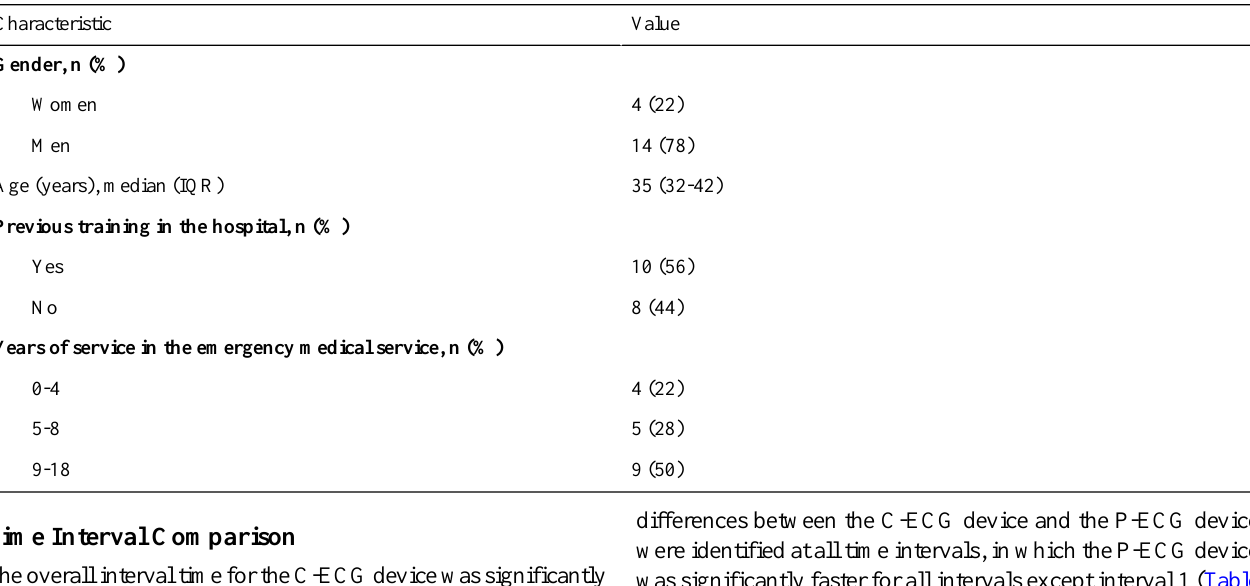
Table 2. Demographic and study-related characteristics of the participants (N=18).